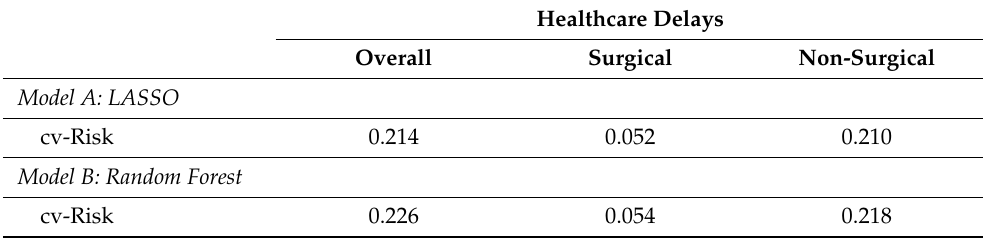
Table 6. SuperLearner models for predictors of healthcare delays–HRS COVID-19